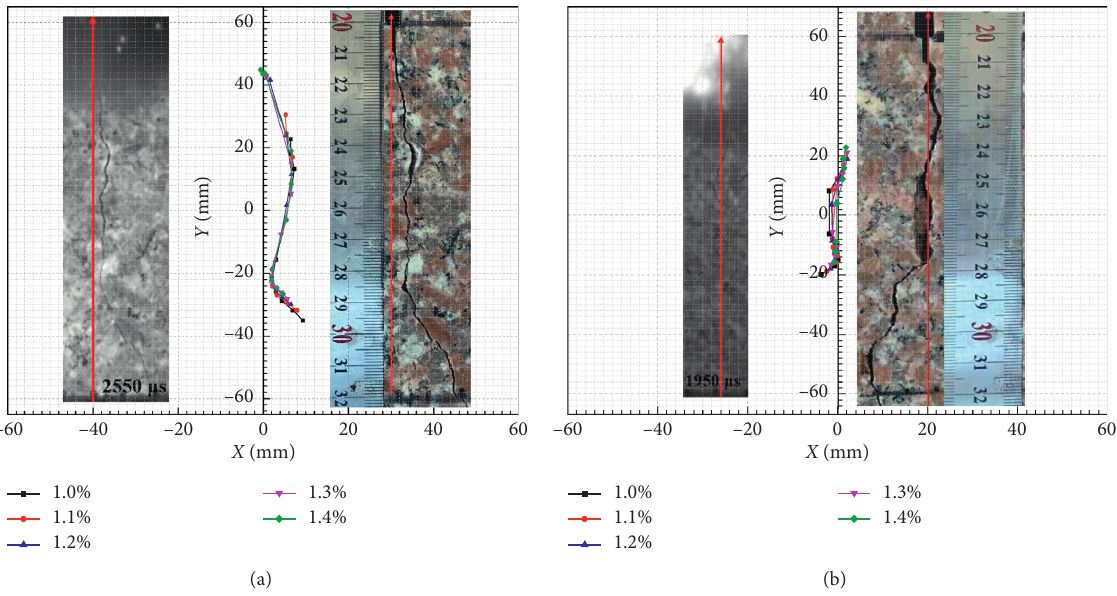
Figure 13: The position of axial strain threshold value tip. (a) Test 1 and (b) test